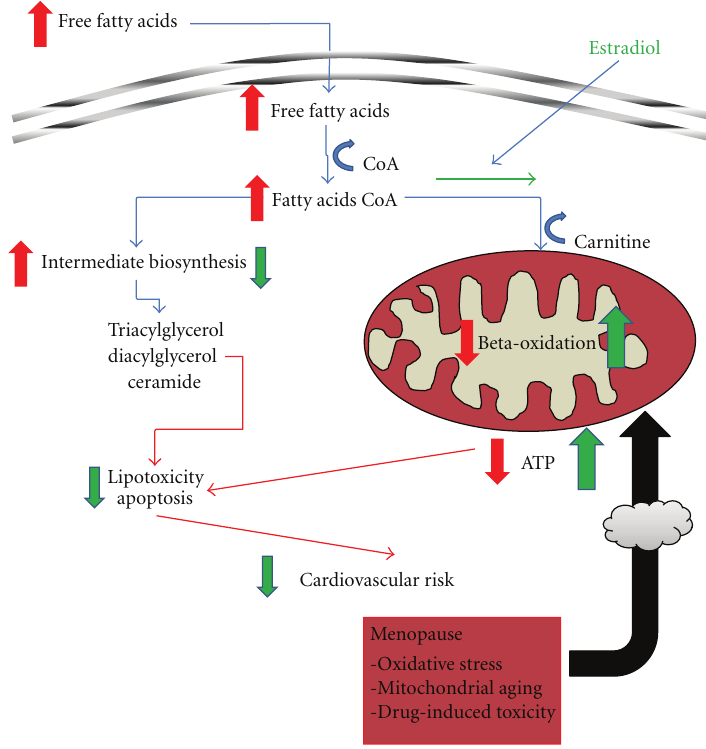
Figure 3: General scheme of the hypothesis raised by the present paper. It is proposed that menopause, as a condition natural to the normal aging process, is accompanied by specific mitochondrial alterations (bottom red box, arrow with a dark cloud) which decrease their ability to cope with an increased flux of long-chain fatty acyl CoA, resulting from augmented plasma levels. Inability to process fatty acyl CoA may result in accumulation of fatty acid intermediates including tri- and diacylglycerol, as well as ceramide, which causes myocardial lipotoxicity and may even result into activation of apoptotic signaling. The cardiovascular risk increases under these circumstances, which is fueled by other coexisting pathological conditions or by pharmacological interventions that present toxicity to the cardiovascular system. Estradiol (represented by green arrows) has been proposed to increase fatty acid oxidation by mitochondria, decreasing the flux through other biosynthetic pathways, preventing the potential accumulation of deleterious metabolites and increasing fatty acid-derived mitochondrial ATP